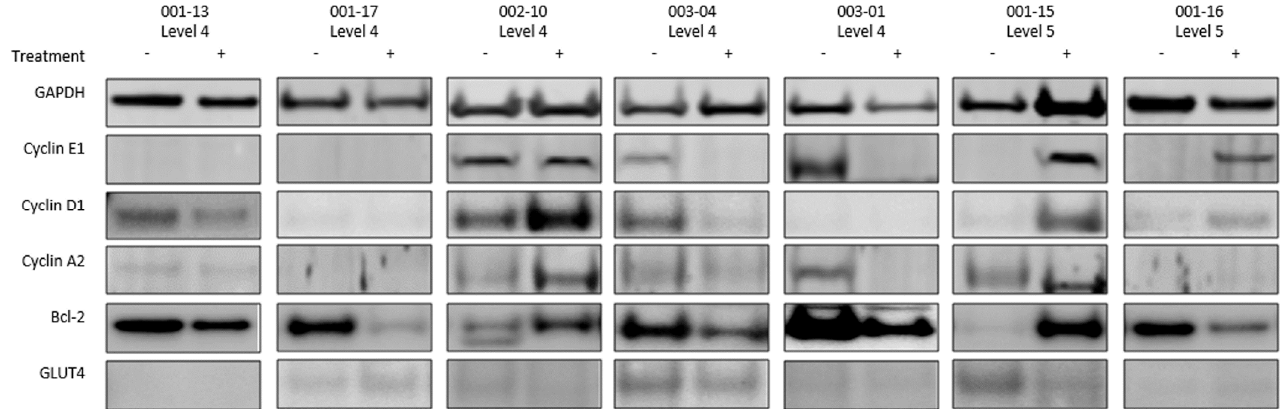
Figure A1. Kaplan-Meier estimates of progression-free survival ( a ) and overall survival ( b ) in all evaluable patients. The vertical lines indicate that patients’ data were censored. The median progression-free survival was 7.6 weeks (range, 3–51 weeks).The median overall survival was 6.0 months (range, 2.4–27.7 months).